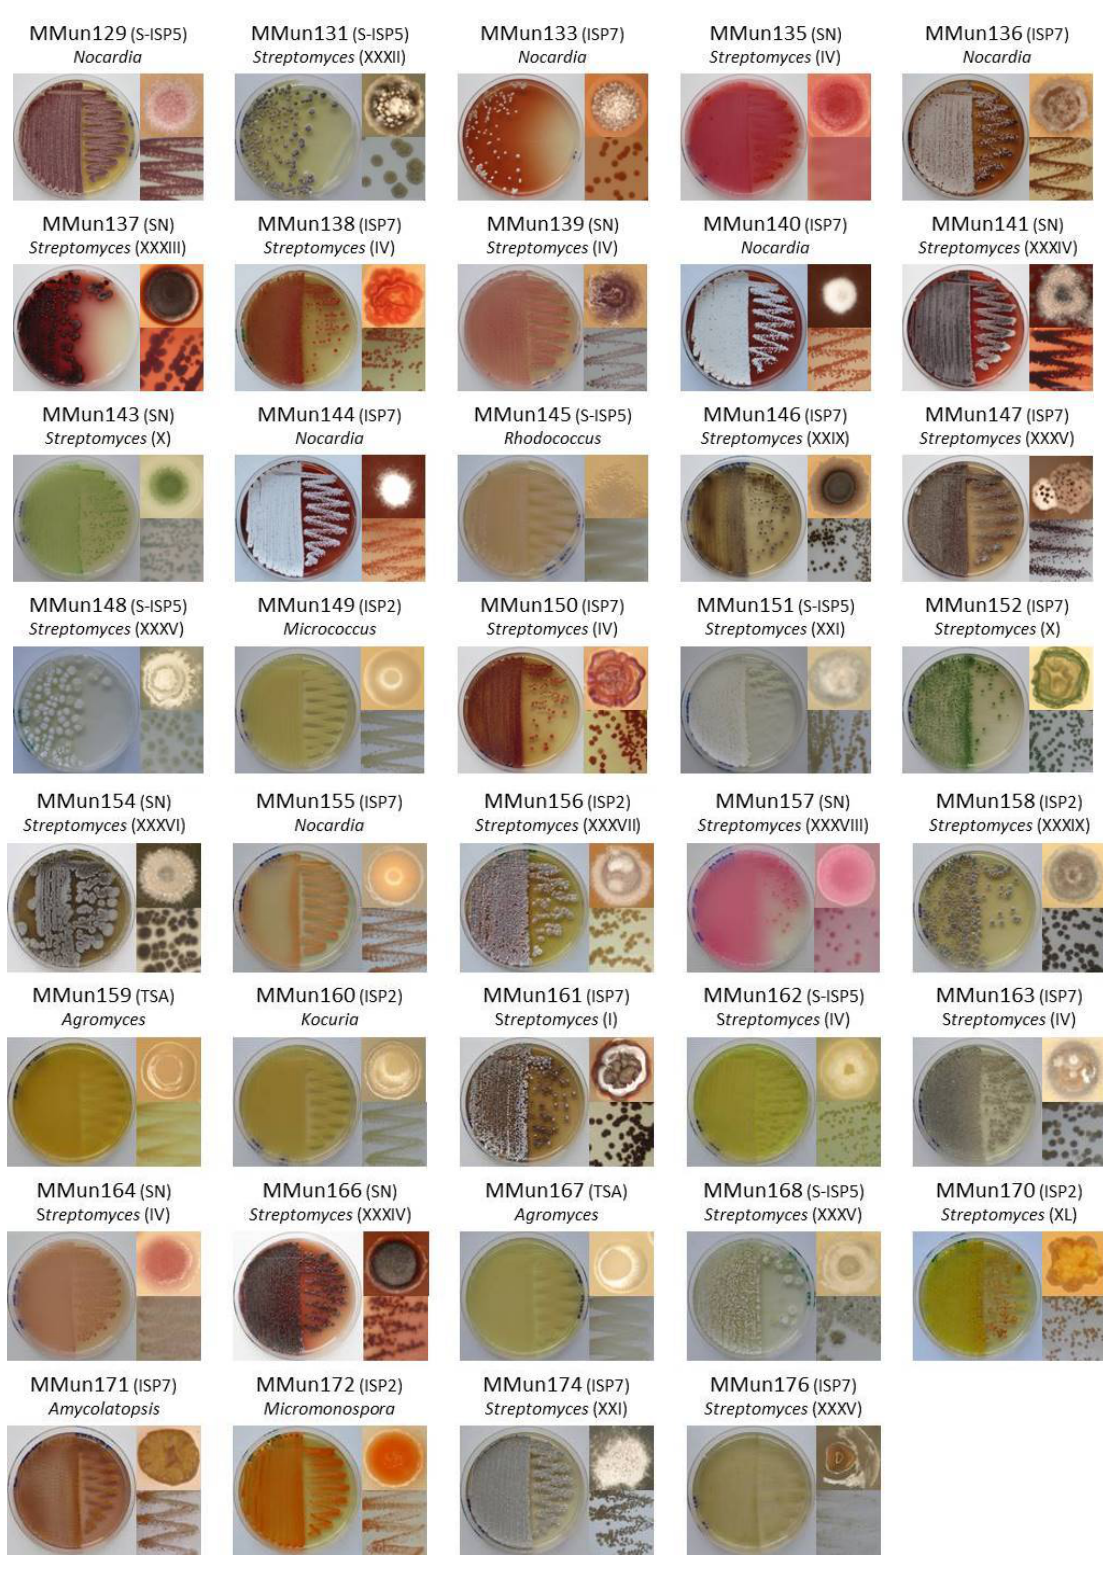
Figure 4. 16S rRNA-based phylogenetic tree of moonmilk-dwelling Streptomyces strains. Strains isolated using the rehydration-centrifugation (RC) method (MMun) are shown in grey, and strains isolated in our previous study (MM) are in black. Phylotype affiliations are indicated in parentheses.